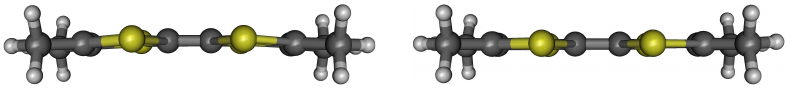
Figure A1. On the left picture, the boat-like equilibrium geometry of the TMTTF 0 molecule.